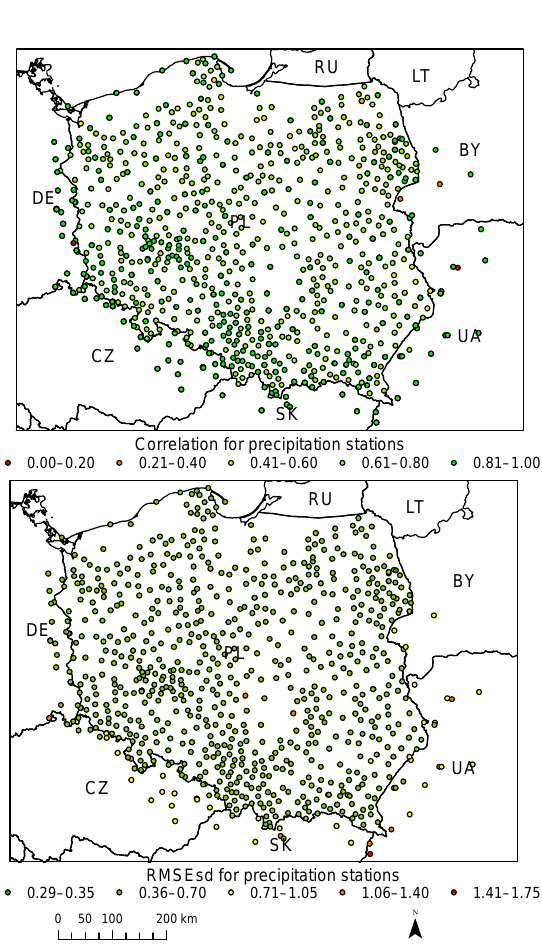
Figure 6. Precipitation ρ (top) and RMSEsd (bottom) values calcu- lated for stations in the period 1951–2013. National borders (black lines) are labelled with country